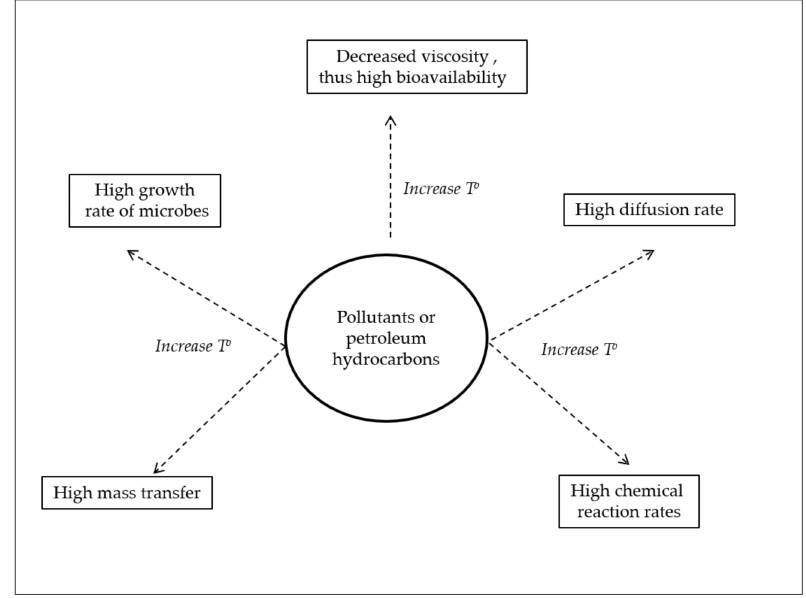
Figure 1. Various advantages of carrying out biodegradation reactions at higher temperatures (T ◦ ), thus, in the presence of